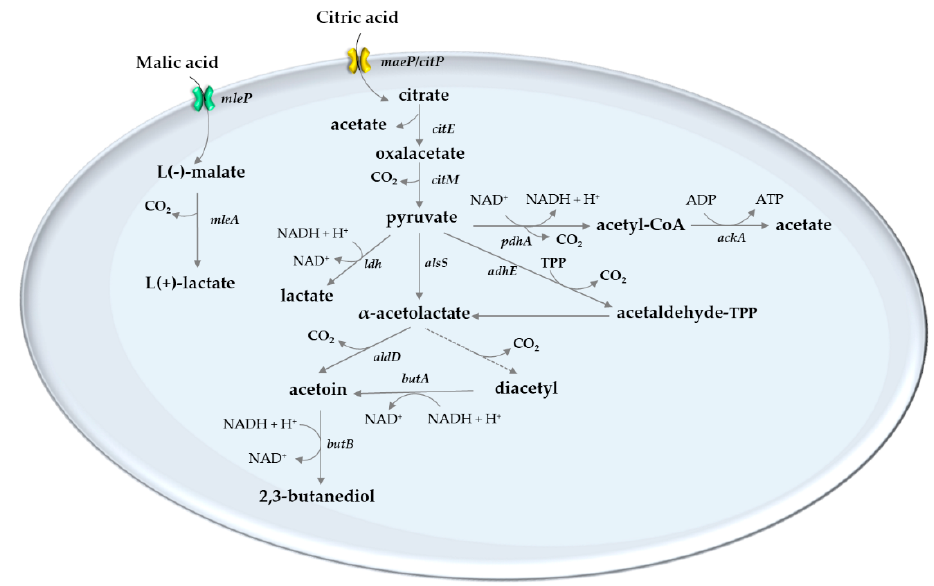
Figure 2. Schematic representation of the pathway for citrate and malate metabolism by lactic acid bacteria. The reactions indicated are catalyzed by the following enzymes: mleP —malate permease;